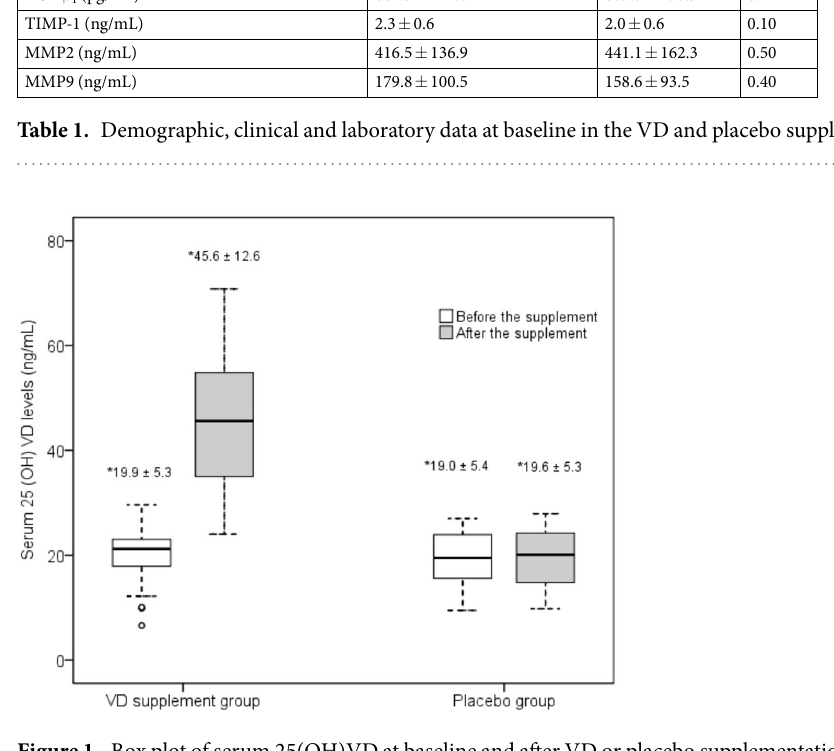
Figure 1. Box plot of serum 25(OH)VD at baseline and after VD or placebo supplementation for 6 weeks. White and gray boxes represent median and interquartile ranges at baseline and 6 weeks, respectively. * Numbers that indicate mean ± SD are shown at the top of each time